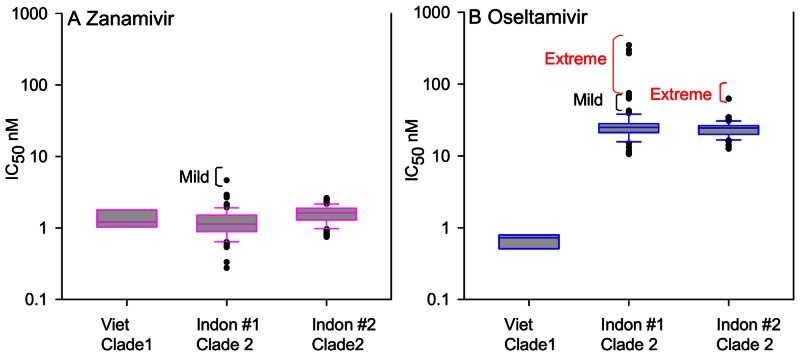
Box plots of means of IC50s for zanamivir and oseltamivir for Indonesian HPAI H5N1 isolates.Means were calculated from the log10 transformed duplicate values, then back transformed. Boxes represent the 25th to 75th percentiles, and horizontal lines within the boxes represent the median values. The difference between the 25th–75th percentiles is defined as the interquartile range (IQR). The ends of the solid lines extending either side of the boxes represent the approximate 95% confidence limits. Mild and extreme outliers lie outside these 95% confidence limits at 1.5x or 3x the IQR respectively from the 75th percentile. Viet clade 1 is the pooled results of all the assays using the reference clade 1.1 A/chicken/Vietnam/08/2004, Indon#1 = clade 2.1 Indonesian samples from batch 1, and Indon #2 = samples from batch 2. (A) Only one outlier was identified for zanamivir whereas there were 8 mild or extreme outliers for oseltamivir (B).